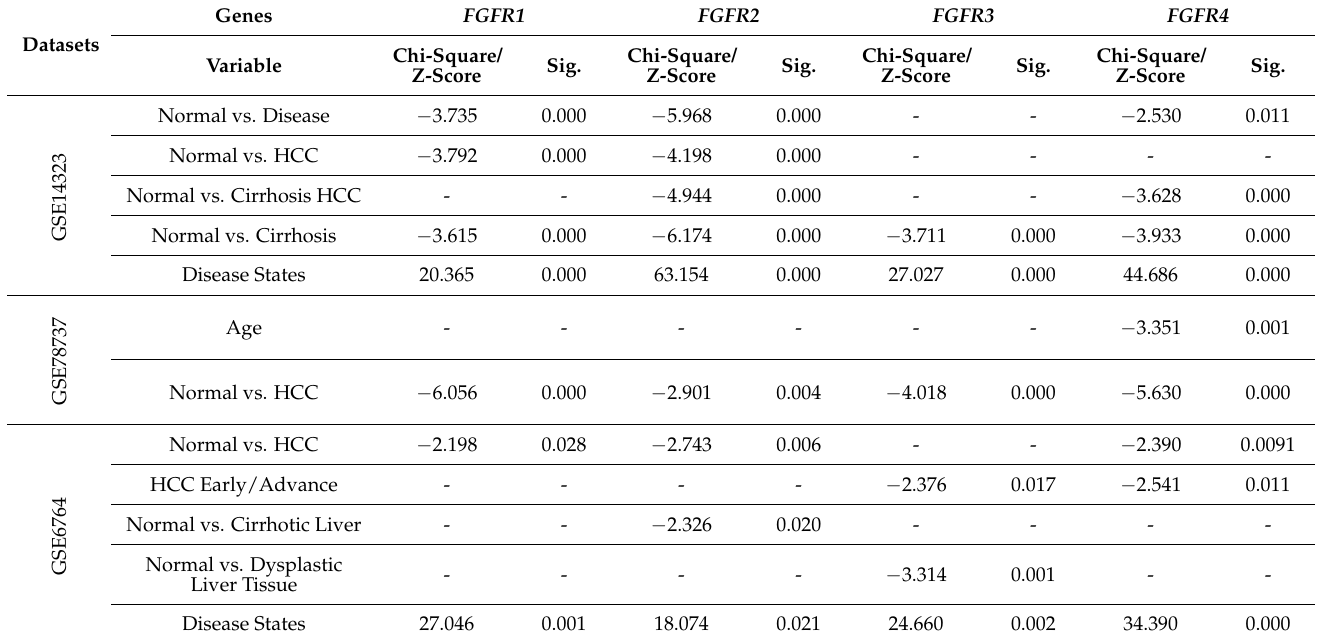
Table 3. Association of FGFRs in three independent